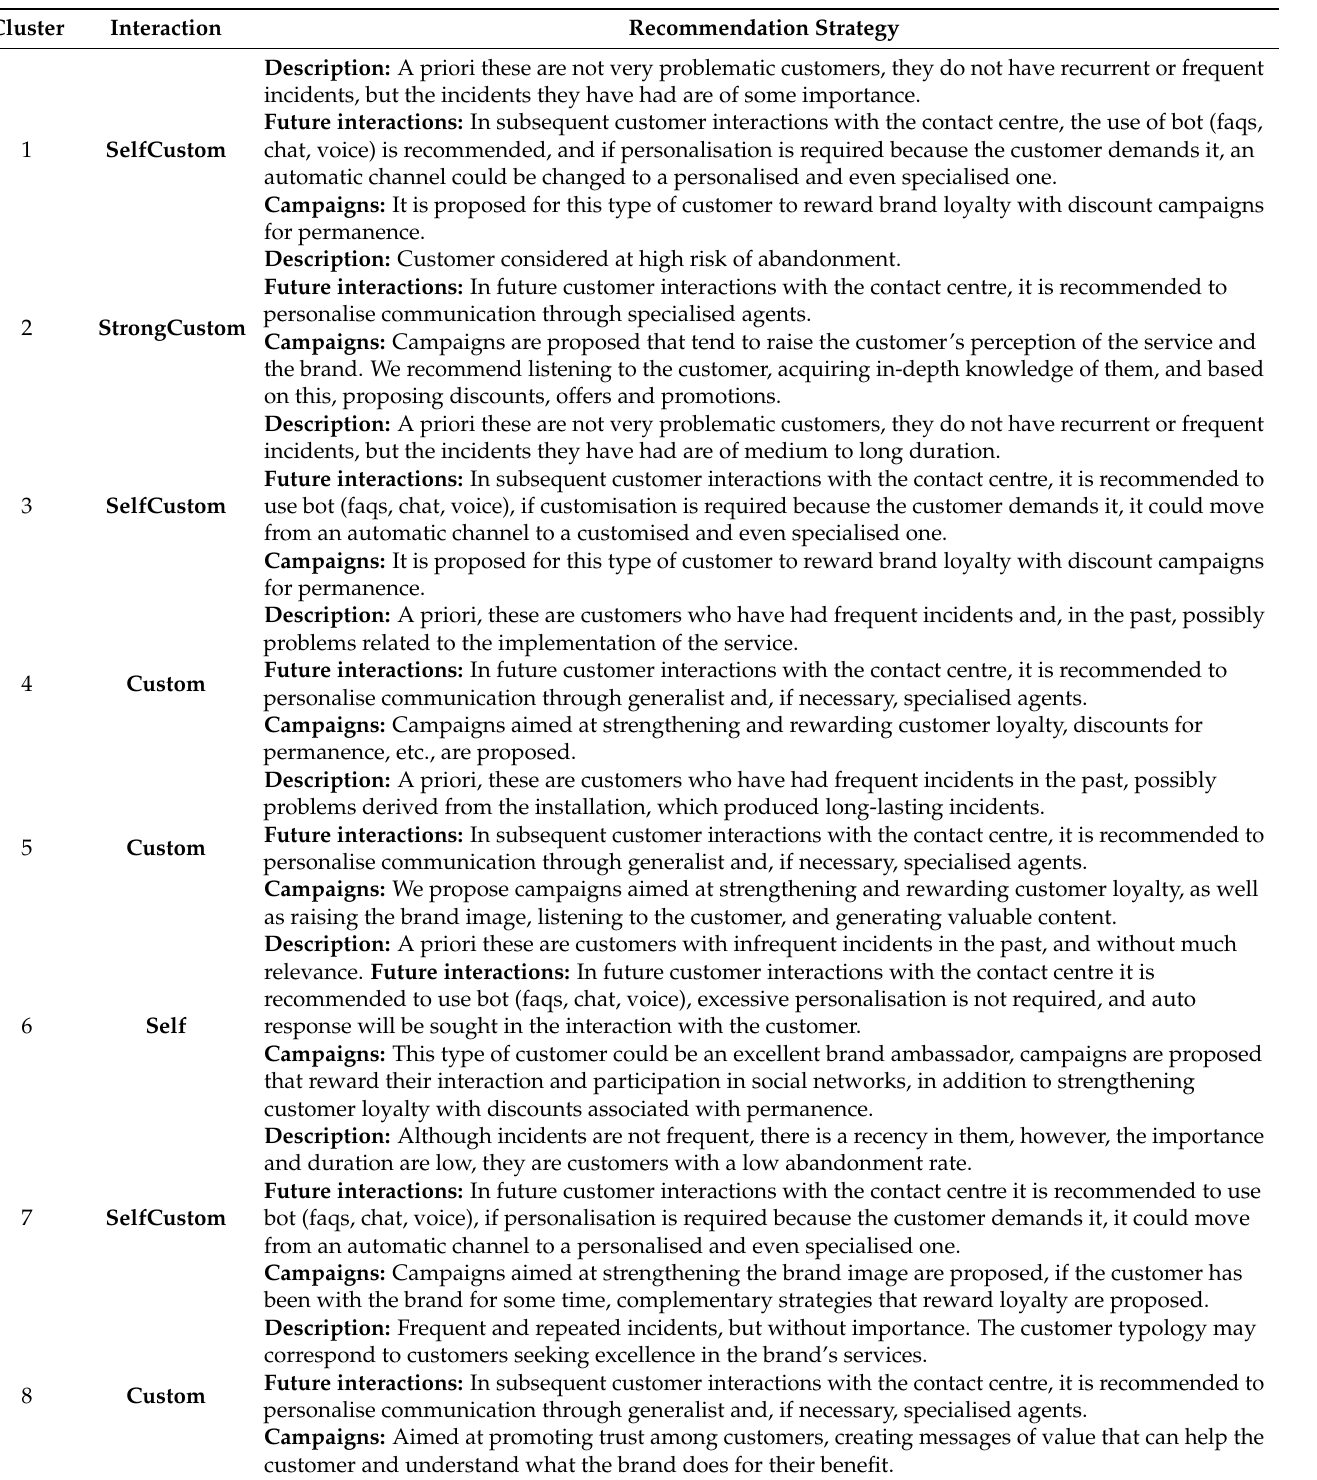
Table 13. Recommendation Strategy by Each